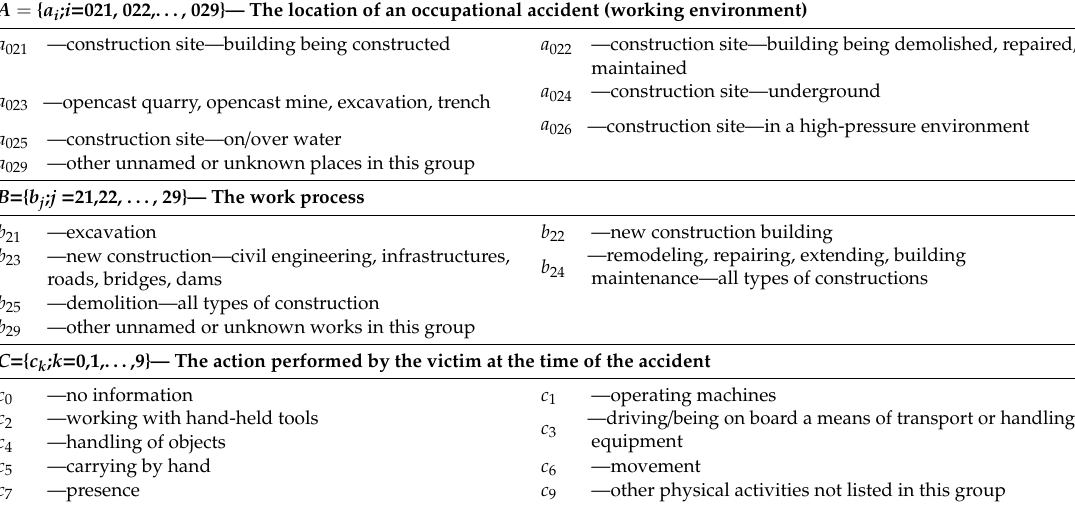
Table 1. Summary of detailed cases in the